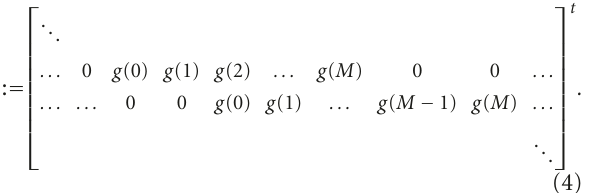
Figure 3: Standard reconstruction structure for